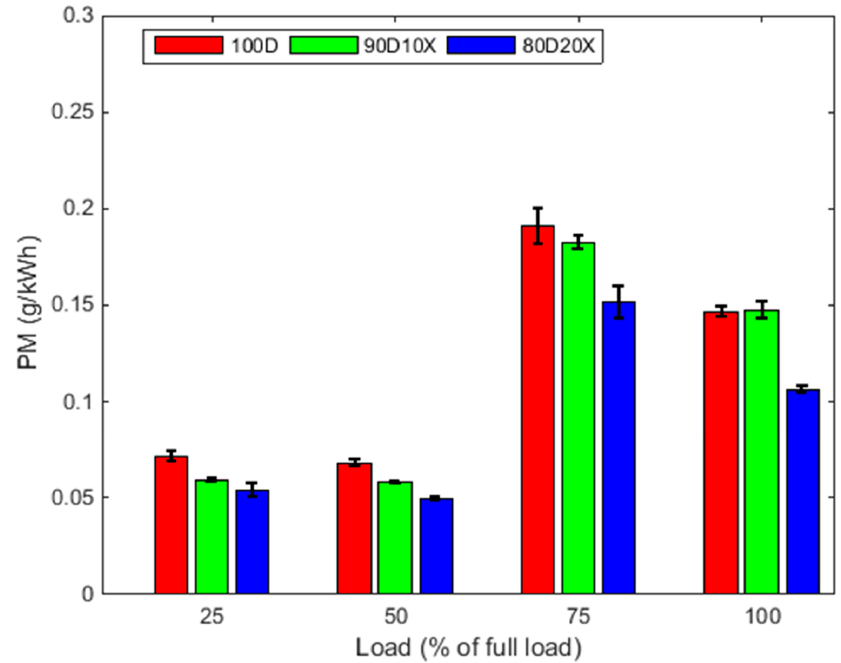
Figure 10. Brake specific particulate matter (PM) emission with engine loads for diesel and DOP blends.